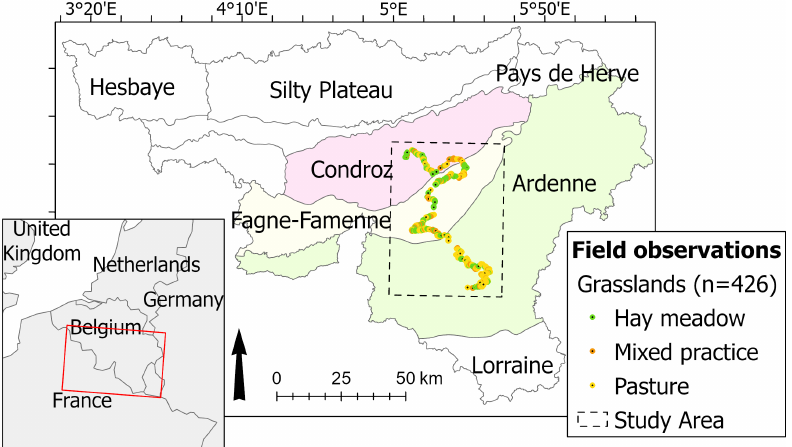
Figure 1. Extent of the study area (Wallonia, Belgium) and location of grassland parcels observed during the field campaign. Orthophoto credits: Service Public de Wallonie